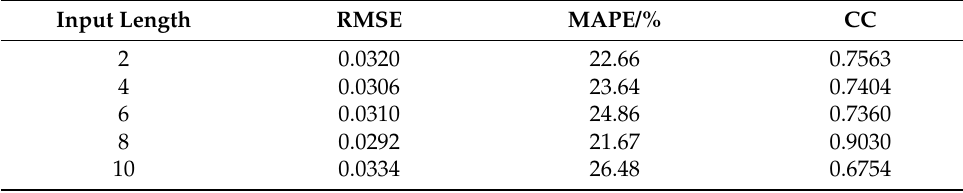
Figure 13. Sequential autocorrelation analysis of CDI. Table 2. Evaluation of prediction effects with different input lengths.